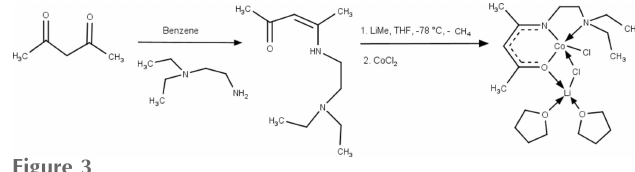
Figure 3 Synthetic scheme for the preparation of the title